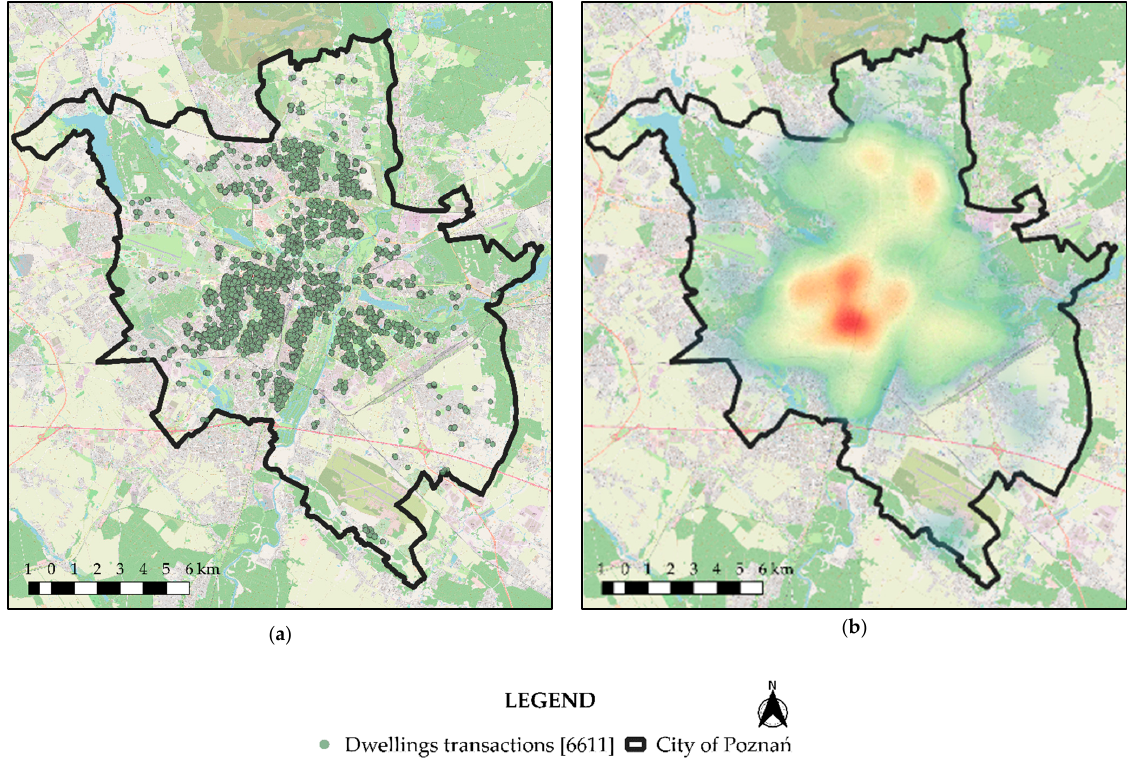
Figure 2. ( a ) Location of housing units analyzed. ( b ) Transaction density within the study area.